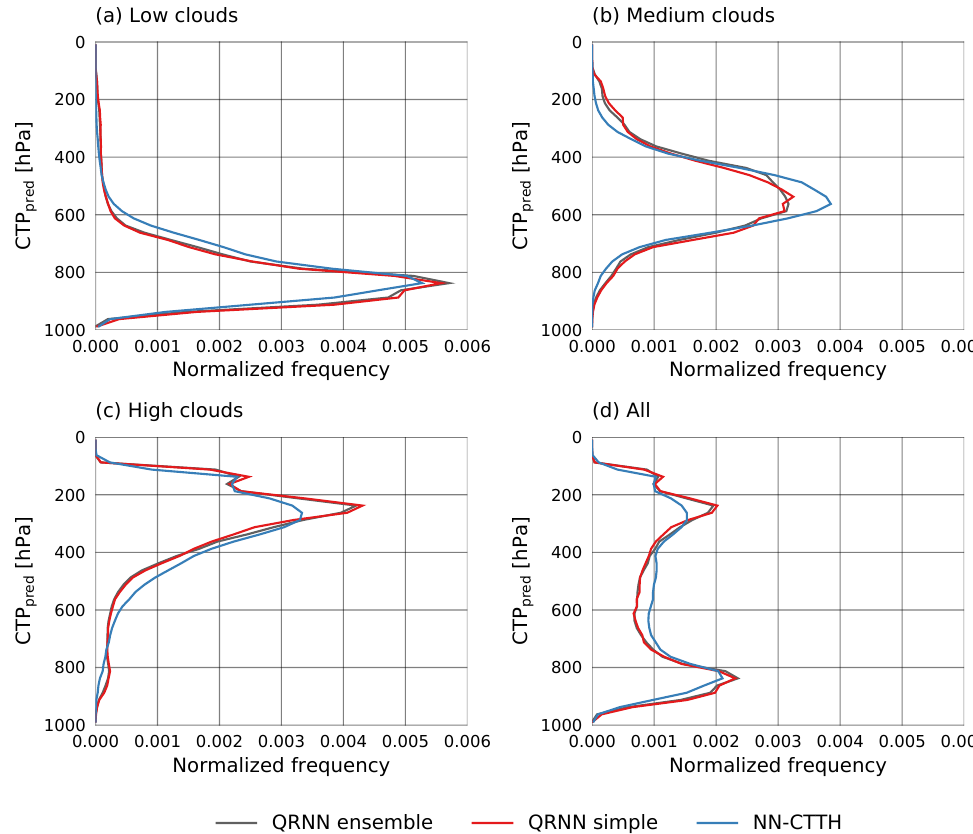
Figure 9. Distributions of predicted CTP values ( CTP pred ) for high clouds (a) , medium clouds (b) , low clouds (c) and the complete test set (d)